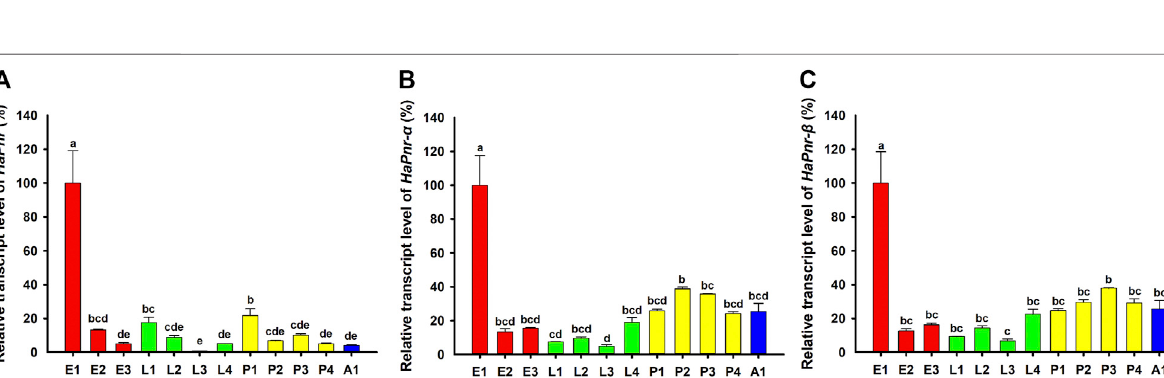
the original melanin synthesis areas are transformed into a yellow color, leading to a loss of color pattern characteristic in the elytra ( Figure 4F ). All the abnormal adults died within 10 days after the eclosion.